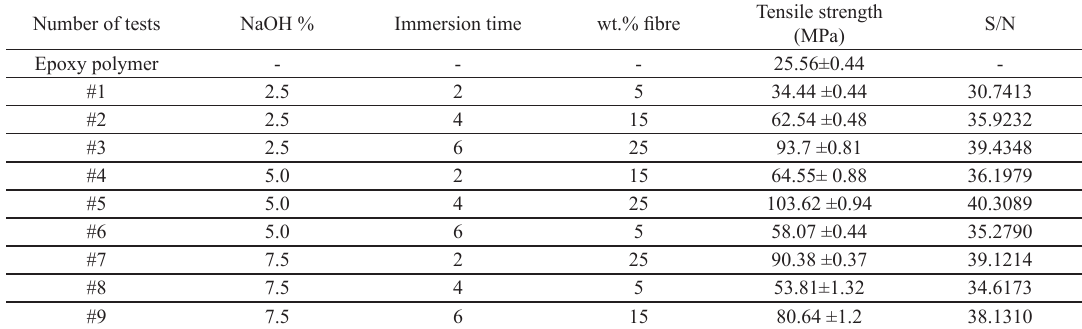
Table 3. L9 Orthogonal